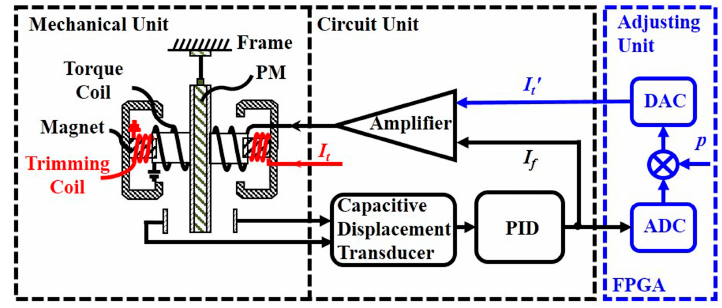
Figure 1. The diagram of a magnetic force rebalance accelerometer with the scale factor trimming. The red signal flow is the Bell’s scale factor adjusting method with trimming coil, while the blue signal flow is the new method with the trimming feedback current presented in this